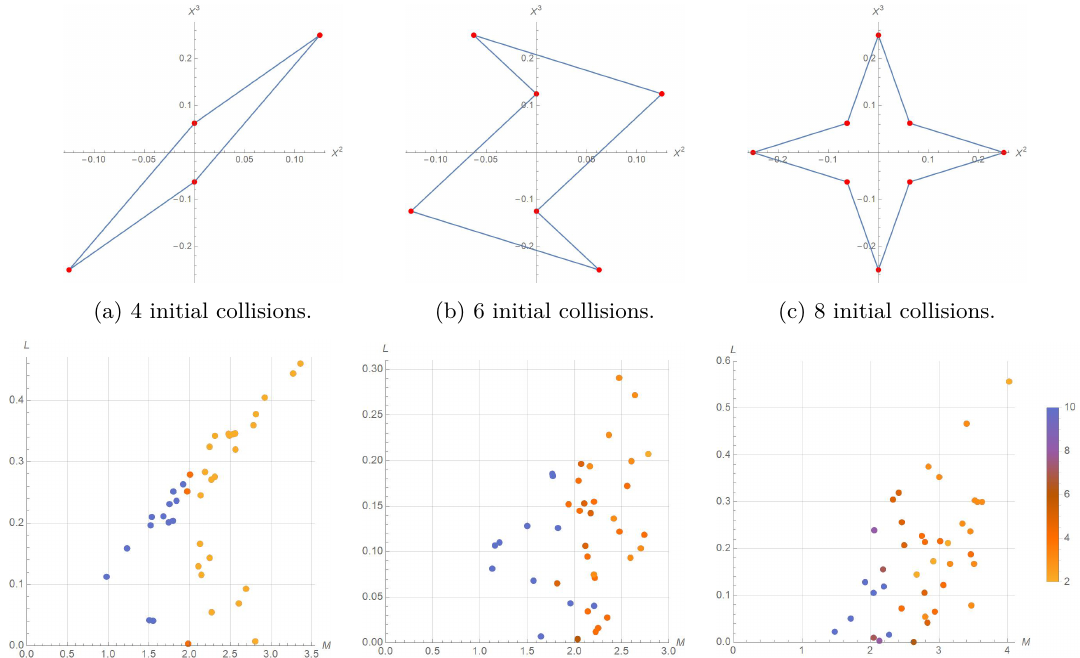
Figure 8 . Considering strings with the above initial collision data X i, − i , we generate random X i +1 , − i , lightlike separated from the initial ones and lying on the dS 3 hyperbola. This then fully determines the motion of the string. For each of the initial configurations we show the angular momentum L versus energy M for a sample of 40 thus randomly generated segmented strings. The color scale shows for how many iterations the string remains within the static patch. We stopped after 10 iterations, so that if the string remains within r ≤ 1 for longer than that, it is also colored in